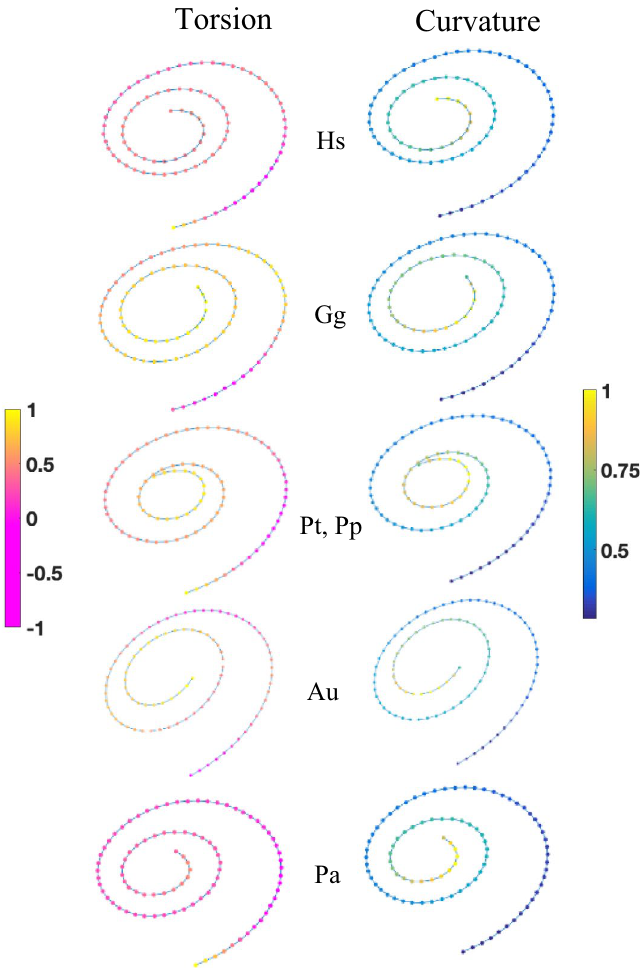
Figure 2. Curvature and torsion of mean cochlear shapes. Mapping curvature (blue to yellow) and torsion (purple to yellow) changes along the Fréchet means from basal to apical locations. Hs Homo sapiens , Gg Gorilla gorilla , Pp Pan paniscus , Pt Pan troglodytes , Au Australopithecus , Pa Paranthropus